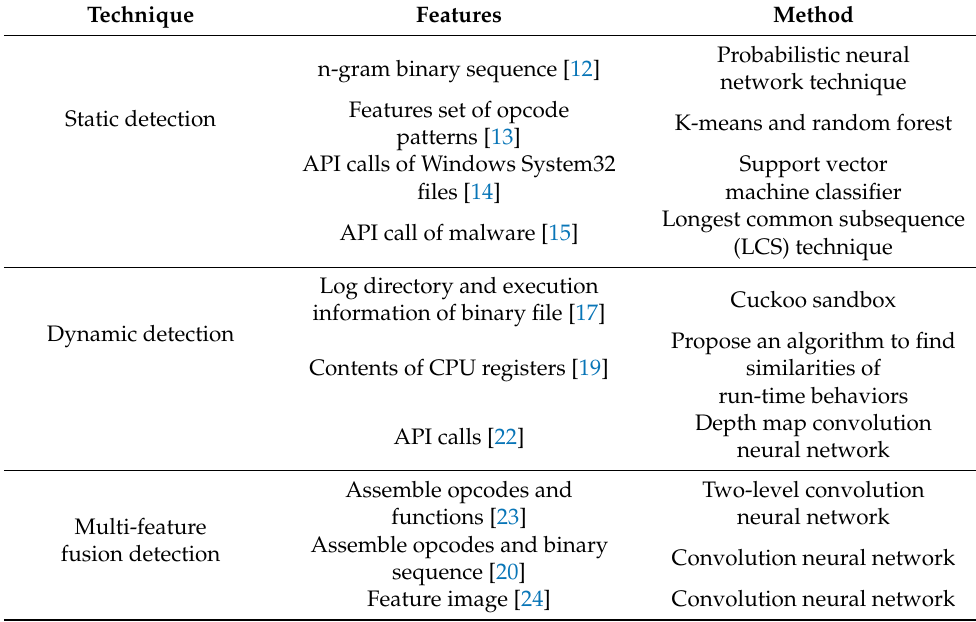
Table 1. The summary of the related